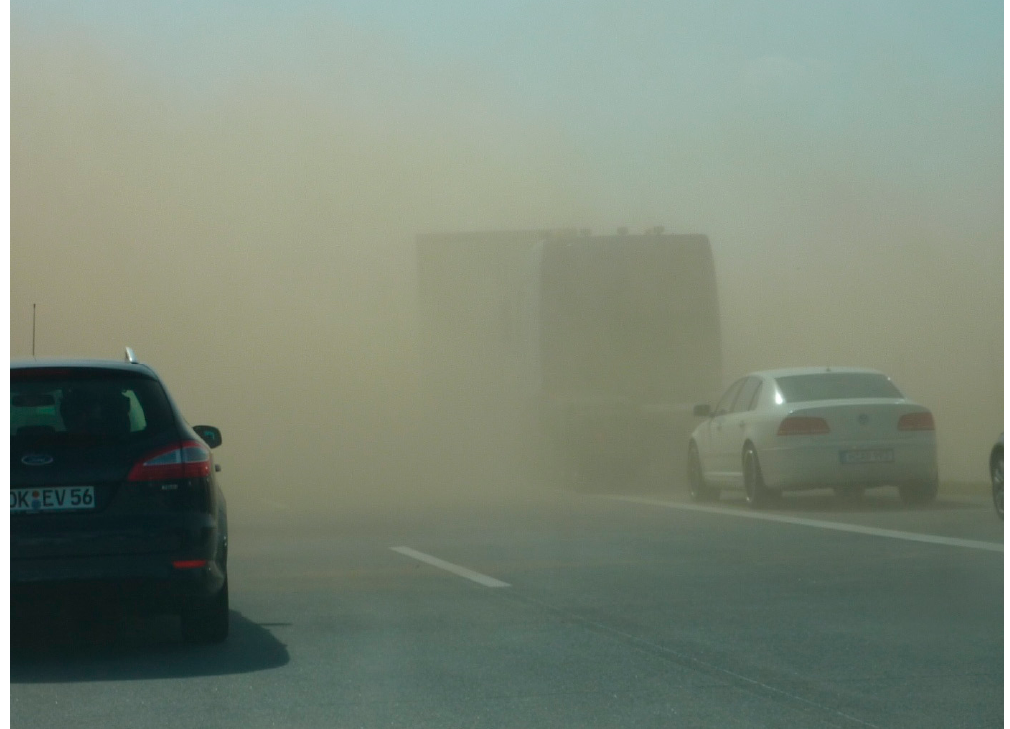
Figure 2. Dust storm on the Highway (Autobahn) 19, south of Rostock, 8 April 2011 (photo: Ch. Opp). A common indicator of dust occurrence is the dust weather frequency (DWF), which expresses the number of days with dust weather events, including dust haze, blowing dust, and storms per year (Fan et al. 2010; Kazakhstan Academy of Sciences 2010). In the northern subzone of Central Asia, on average, 20–30 dust storms occur per year, with 28 such events along the Syr-Darya and Ili river valleys, and 30 dust storms in the Lake Balkhash area. In all these areas dust storms occur predominately between April and October, while the surfaces are mostly covered by snow between November and March. In the southern subzone, dust storms may occur around the year. Thus, in the central Karakum Desert on average 60 dust storms occur, while the averages for the eastern and western Karakum desert are 62 and 67 dust storms per year, respectively (Orlovsky et al. 2009; Opp et al. 2016). However, the plain number of dust storms per year is only one facet of the temporal dust storm variability. Some of these registered storms might only last for less than one hour, while others last for more than 24 h. Moreover, while some dust storms can be categorized as comparatively mild (12.5% of all detected dust storms within the CALTER project deposited less than 1 kg of dust per hectare and hour), others can be severe (10% of the dust storms deposited more than 100 kg/ha/h, for a maximum of 1.87 tons of deposited dust per hectare in a single dust storm